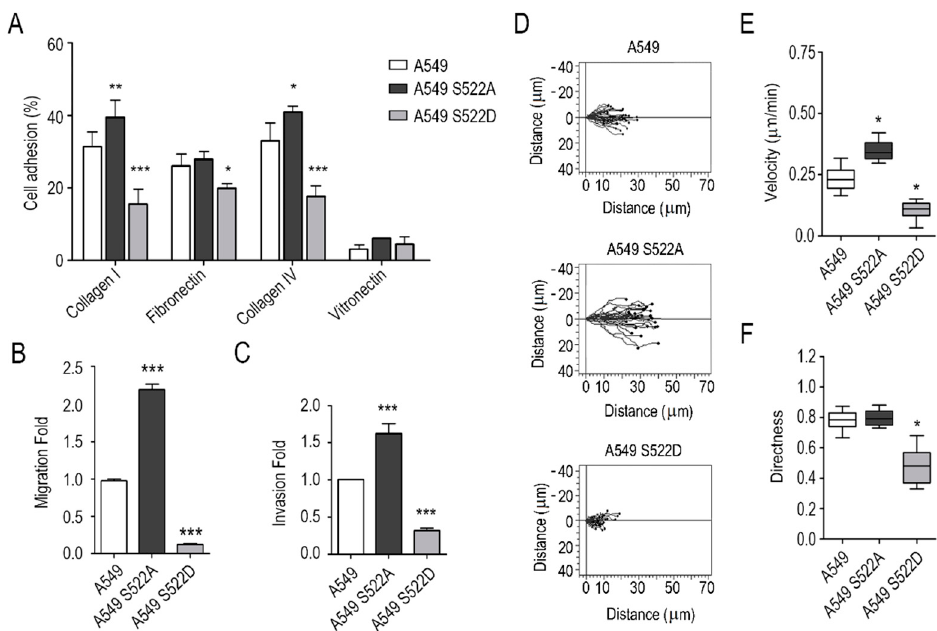
Figure 4. Invasion and adhesion of A549 cells expressing CRMP2 phosphorylation mutant forms. ( A ) Cell adhesion to collagen I (50 µ g/mL), collagen IV 50 µ g/mL), fibronectin (10 µ g/mL) and vitronectin (1 µ g/mL) coated surfaces. Results are shown as the percentage of cell adhesion relative to BSA. (Number of wells, n = 12); ( B ) Boyden migration assays towards cell media containing 20% FBS. Data are shown as a fold ratio over wild-type A549 cells. (Number of images, n = 12); ( C ) cell invasion assays across Matrigel hydrogel coated Boyden chambers. Data are shown as a fold-ratio over wild-type A549 cells. (Number of images, n = 12); ( D ) single representative cell tracks of cell movement during wound-healing assays. Cell migration was captured by confocal video-microscopy every 10 min during 12 h. (Number of videos, n = 3); ( E , F ) quantification of cell speed ( μ m/min) and directness from videos shown in ( D ) using the Chemotaxis and Migration software. (Number of cells, n = 60). *** ( p < 0.001). ** ( p < 0.01). * ( p < 0.05).